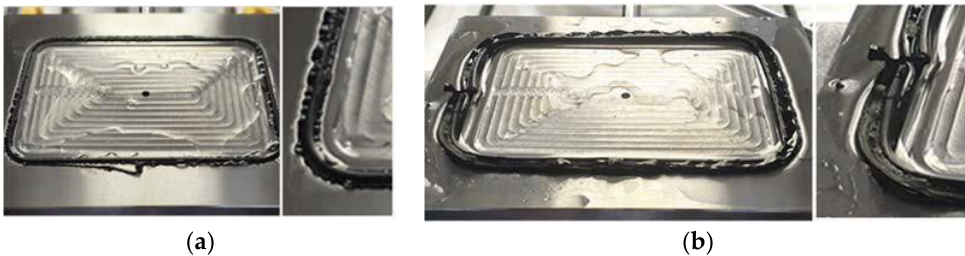
Figure 7. O-ring sealing-failure cases: ( a ) O-ring starts to flow and ( b ) O-ring seal failure at 200 MPa.